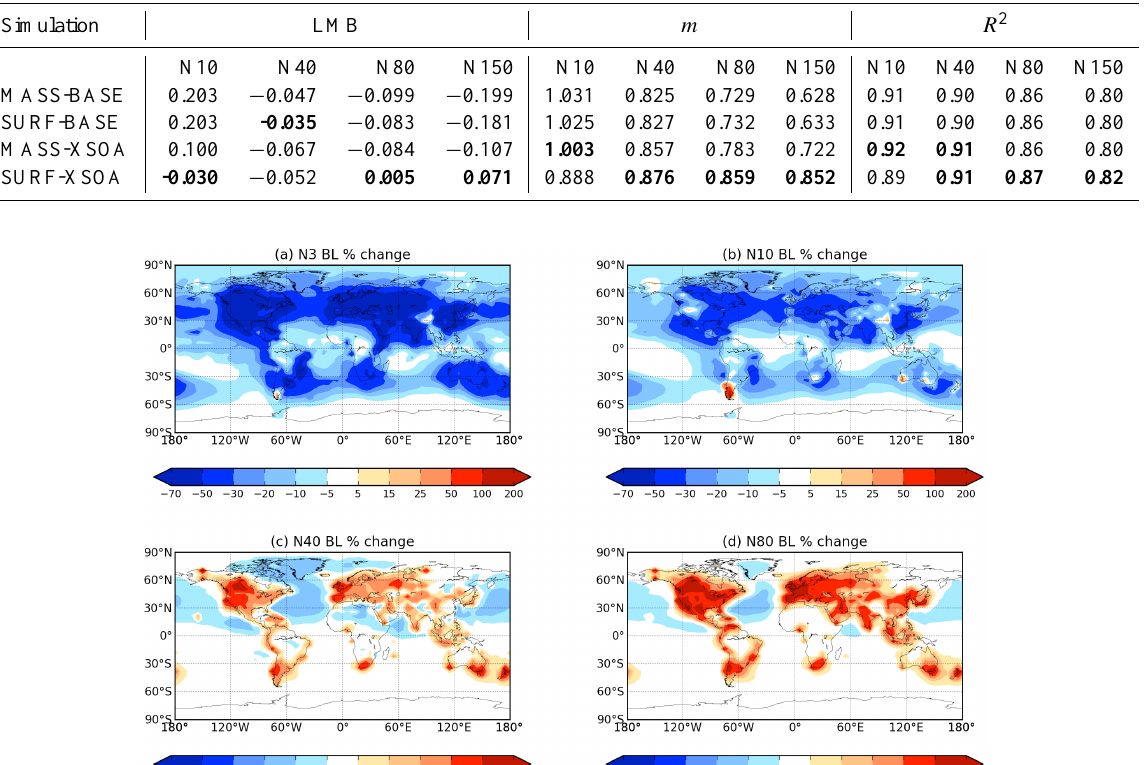
Fig. 3. Global annual-mean BL changes in (a) N3, (b) N10, (c) N40 and (d) N80 between SURF-BASE and SURF-XSOA (red denotes higher concentrations in the SURF-XSOA simulation). The inclusion of an additional 100Tg(SOA)yr − 1 spatially correlated with anthropogenic CO emissions (Spracklen et al., 2011b) caused global decreases in N3 and N10 of 50.9% and 26.6% respectively, however global increases of 13.7% and 29.9% in N40 and N80 respectively.